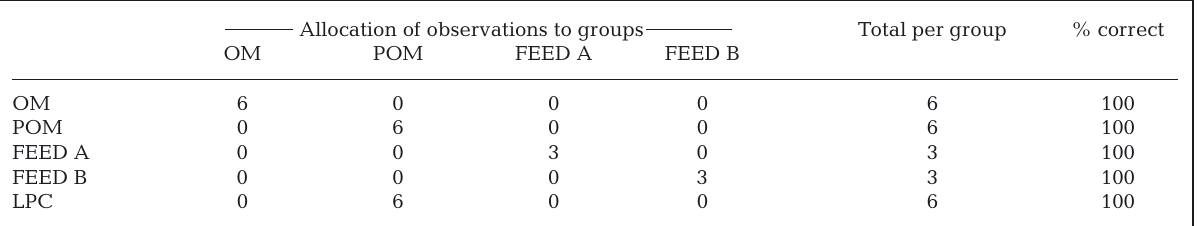
Table 3. Cross validation success of large Hediste diversicolor (LPC) fatty acid (FA) profile based on FA profiles of organic matter (OM), particulate organic matter (POM) and fish feed (FEED A and FEED